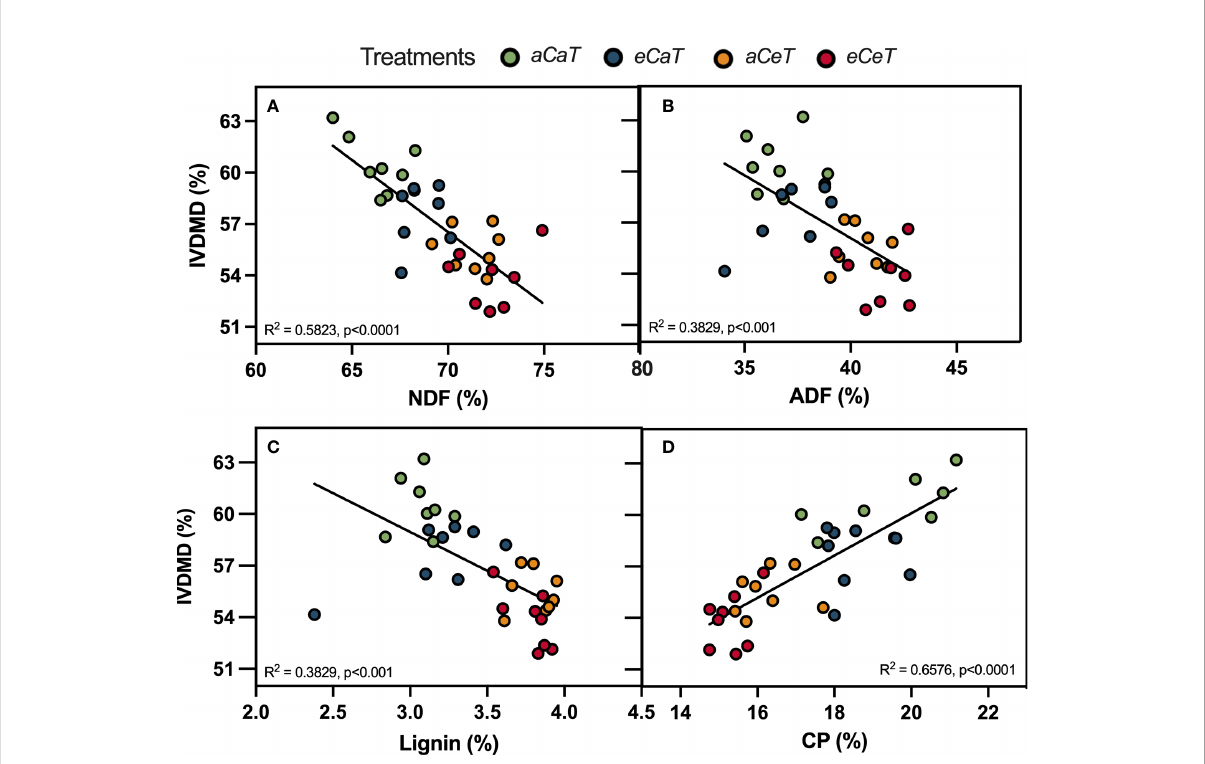
FIGURE 6 Linear regressions between for age nutritive value parameters and in-vitro dry matter digestibility (IVDMD) of M. maximus above ground dry mass measured at different levels of [CO2] and temperature. (A) NDF, neutral detergent fi ber. (B) ADF, acid detergent fi ber. (C) Lignin. (D) CP, crude protein. R2 and p-values are shown for each regression line. Treatments: aC (ambient CO 2 concentration), eC (elevated CO 2 concentration – 600 ppm), aT (ambient temperature), and aT (elevated temperature - 2°C above ambient